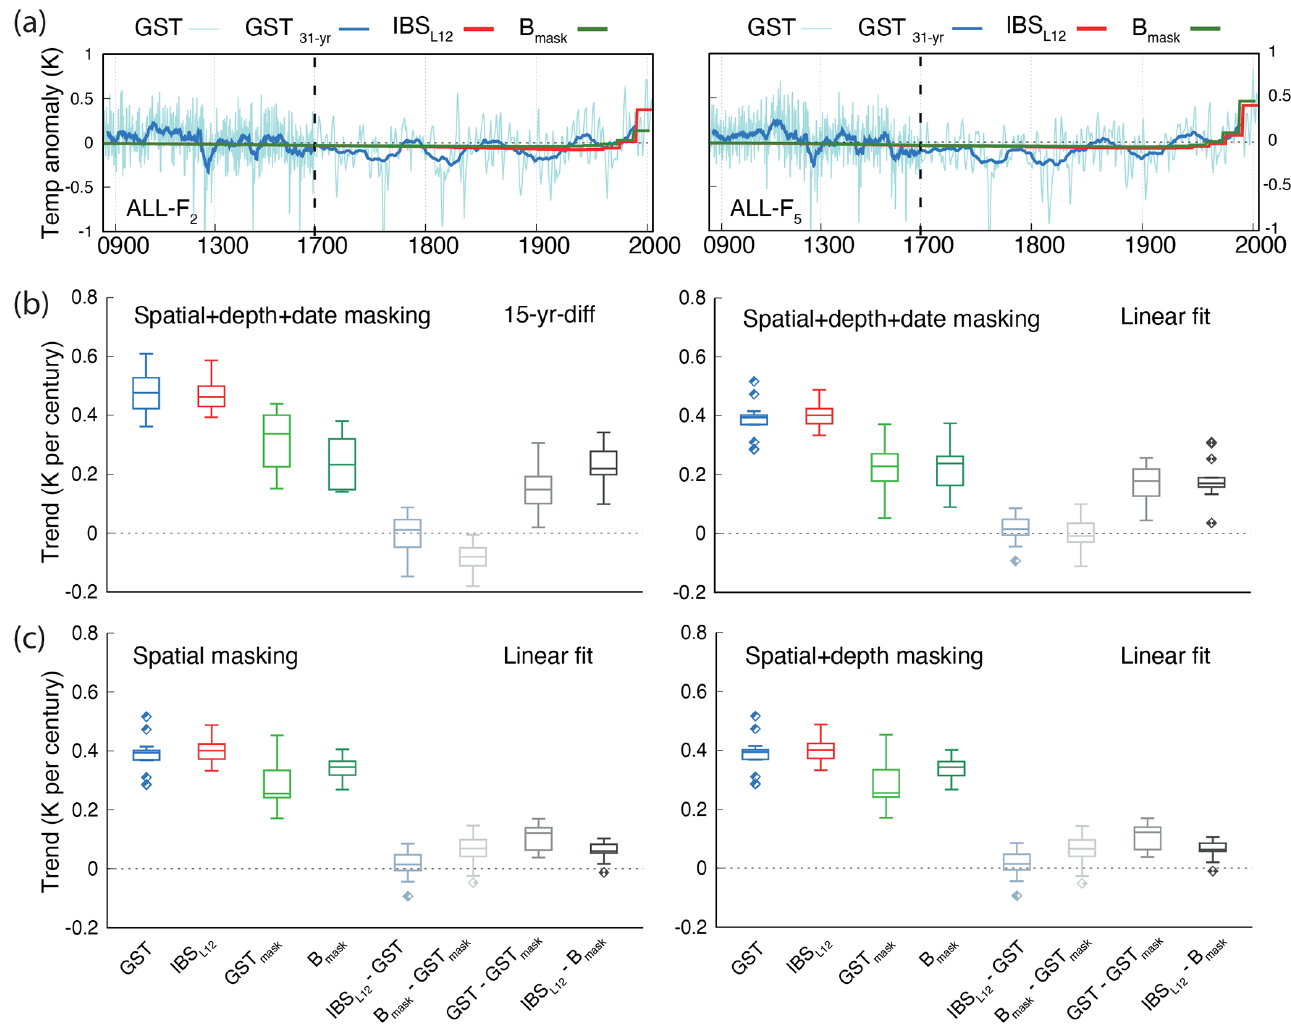
Figure 2. (a) LM global GST annual anomalies and the corresponding 31-year filtered output and the global IBS L12 and B mask pseudo- reconstructions for the ALL- F 2 and ALL- F 5 members of the ALL- F ensemble. Note the different discretization in the x axis after 1700CE. (b) Boxplots describing the centennial trends over the period 1900–2005CE, calculated for each of the 13 ensemble members within ALL- F after applying space, depth and time masking in the model to mimic real BTP distribution. Boxplots of trend differences have been created by subtracting individual trends, following Santer et al. (2008). Panel (c) as in (b) but applying spatial and depth masking (right) and only spatial masking (left). GST, IBS L12 , GST mask , B mask and the differences between IBS L12 − GST, B mask − GST mask , GST − GST mask and IBS L12 − B mask cases are represented. Trends are presented as the 15-year-difference case ( b left; see text) and the linear fit to the data calculated over an annual basis ( b right). The 25th, 50th and 75th percentiles are indicated, and the whiskers represent the lowest/highest value within 1.5 interquartile range (IQR) of the 25th/75th percentile. Outliers are indicated as diamonds in the same color of the box. They represent the values lower/higher than the lower/upper whisker. Note that colors in (a) correspond with those in (b) and (c)